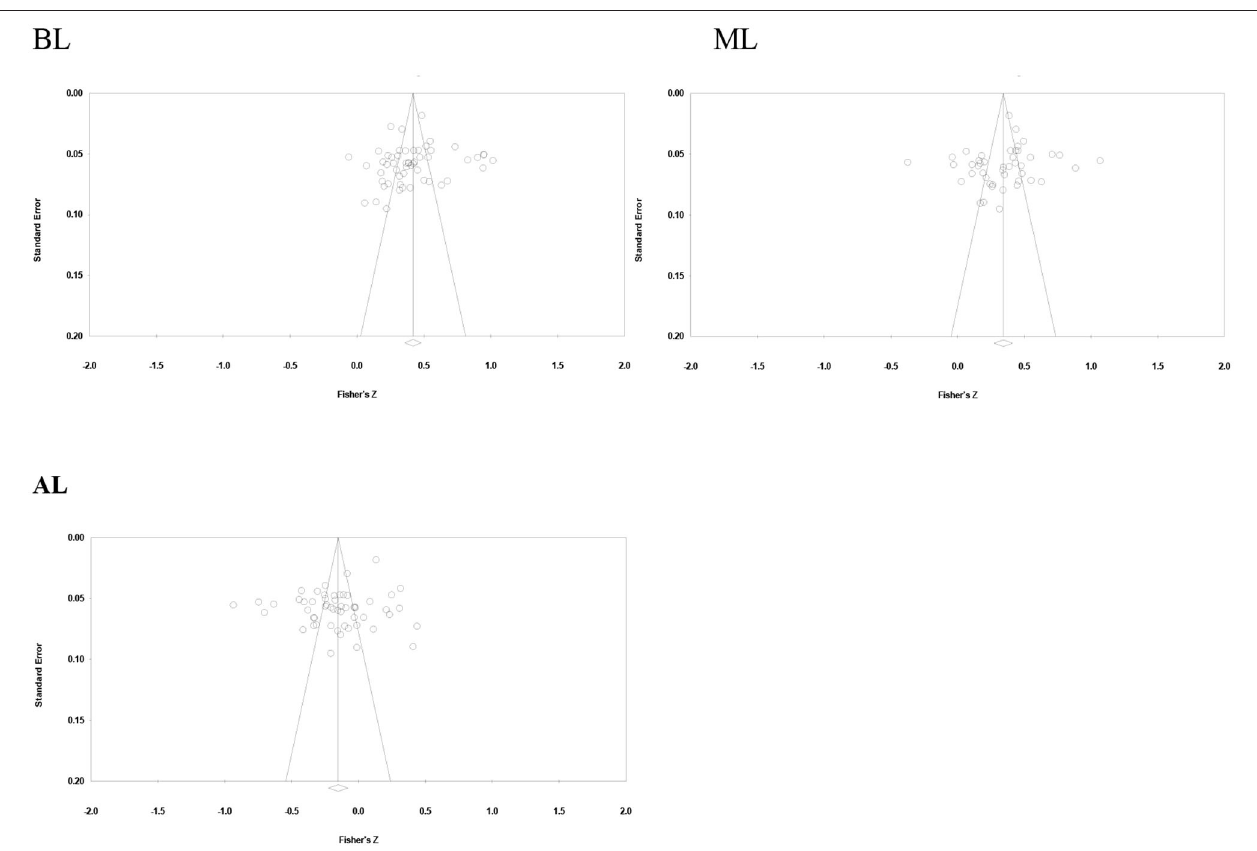
or above could positively predict the effect sizes of BL and ML but negatively predict the effect sizes of AL, supporting H5 and